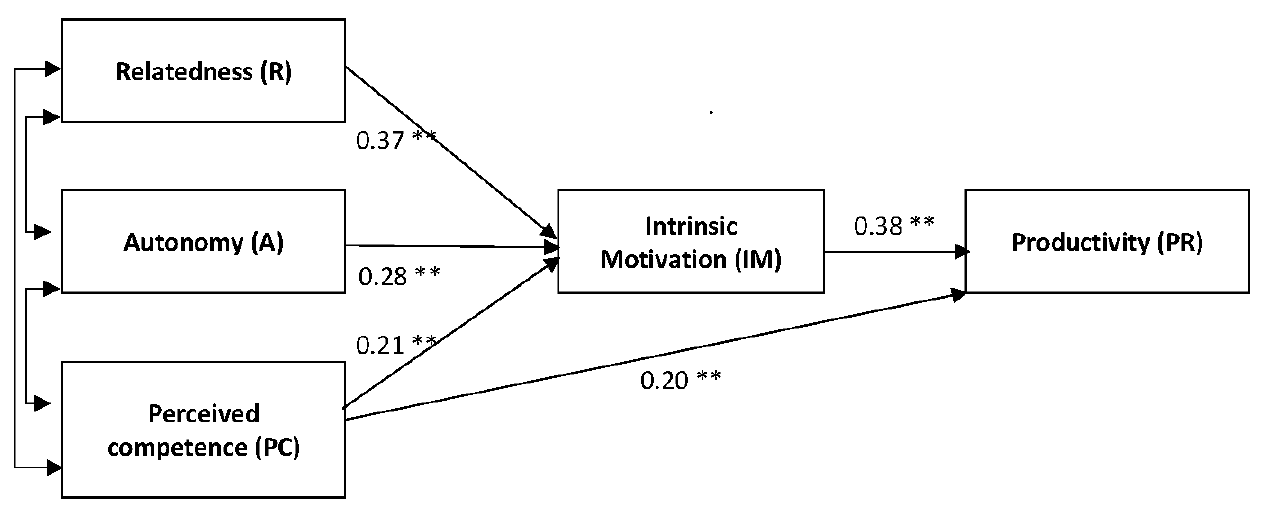
Figure 2. Standardised regression coefficients Model 3. ** p < 0.01.